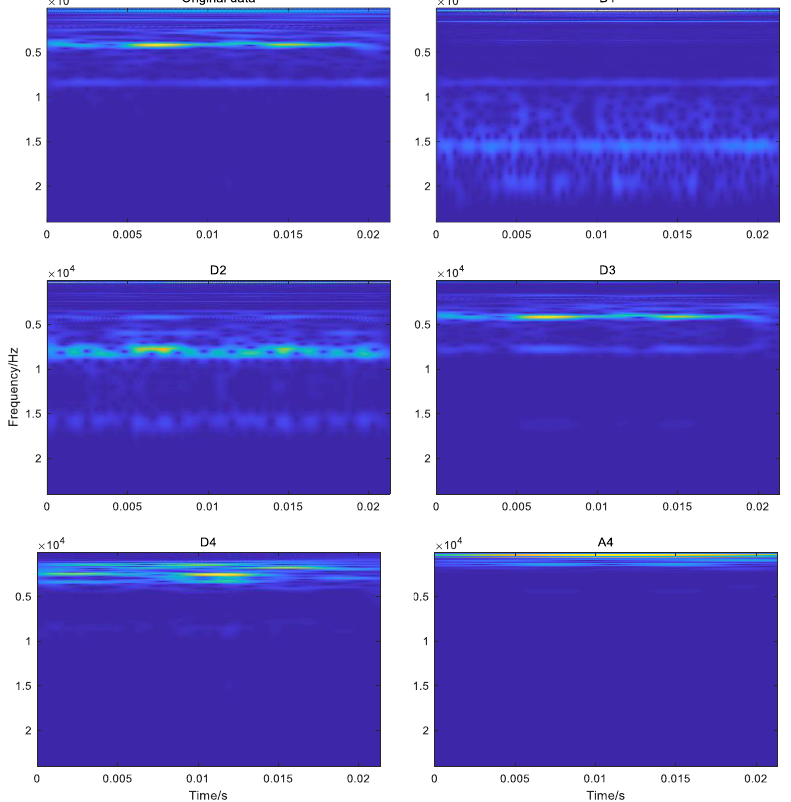
Figure 11. TFR maps of subsignal and original vibration signal.